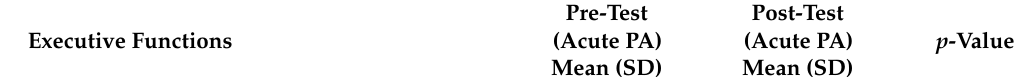
Table 1. Results of the effect of acute PA on BDNF and the different executive functions in